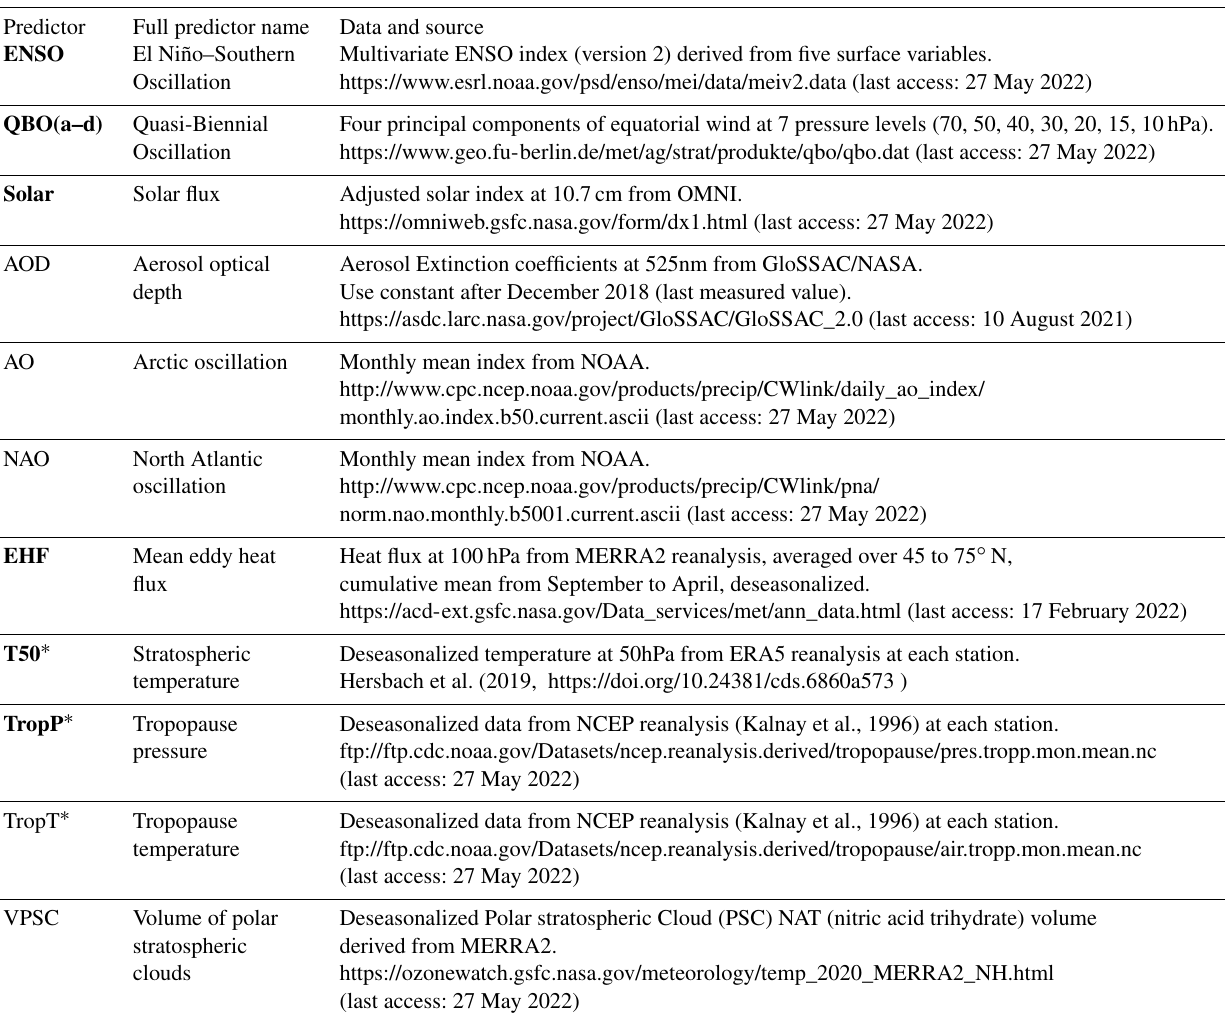
Table 2. Predictors investigated for use in the multiple linear regression. Predictors that have been used in the final regression are marked in